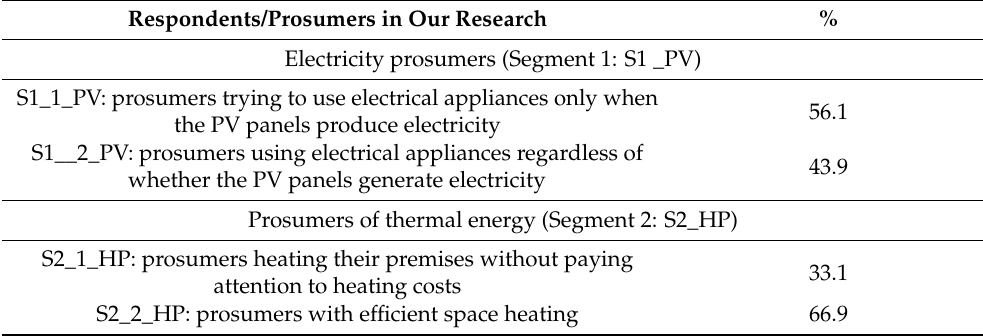
Table 5. Impacts of owning installations on changes in prosumers’ energy